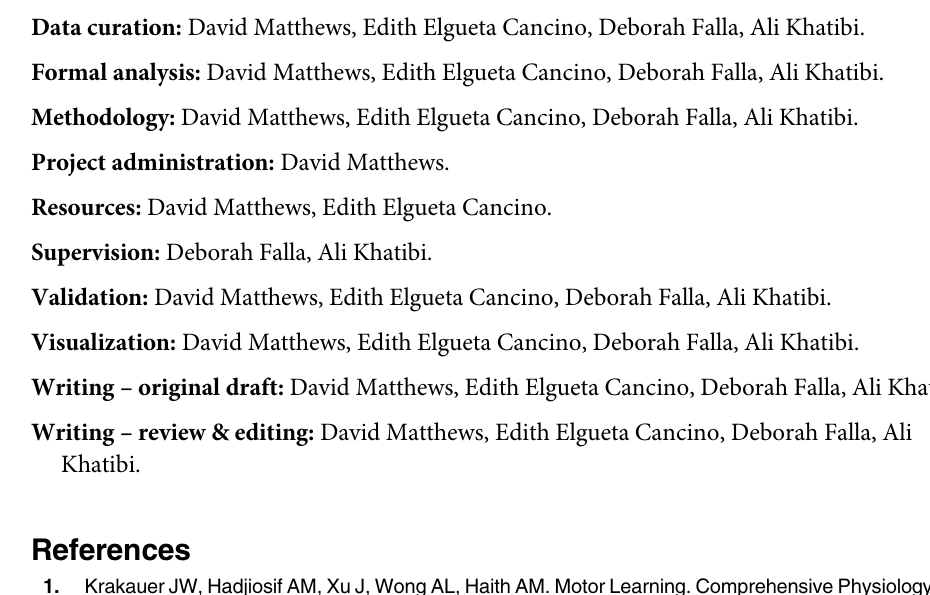
S1 Fig. Fig 3 Bubble chart displaying impact of pain on task performance across motor learning for spatial and temporal measures during acquisition and retention. Outcome measures from 18 studies: 15 tonic experimental and five clinical pain. S2 Fig. Fig 4 Bubble chart displaying impact of pain on activity dependent measures across motor learning during acquisition. Outcome measures from 18 studies: 15 tonic experimen- tal and five clinical pain. S1 Table. Tables 8–10 Summary of GRADE judgements for all outcome